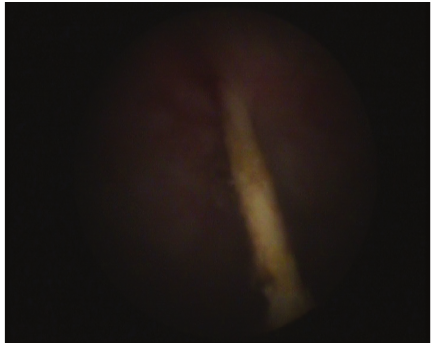
Figure 2: Cystoscopic view of IUD.